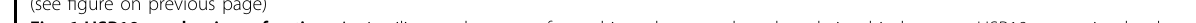
Fig. 6 USP19 mechanism of action. An in silico study was performed in order to analyze the relationship between USP19 expression levels and different pathway activation status. A USP19 mRNA expression among primary breast carcinomas according to their intrinsic subtype. Expression analysis showed a consistent upregulation in luminal A and B subtypes compared with basal-like and Her2 subtypes. B Luminal A/B primary breast cancers divided into low ( n = 77) or high ( n = 209) USP19 mRNA expression levels. C Signi fi cantly activated pathways among Luminal A/B tumors with high USP19 mRNA expression ( n ≥ 77, SAM test, p < 0.01). Western blotting was performed in order to analyze LRP6 protein expression in breast cancer cells upon USP19 genetic manipulation. D Top: Western blot quanti fi cation in control or USP19 silenced MDAMB231 cells ( n = 6, one-way ANOVA, Dunnett ’ s multiple comparison test. shRNA#1 p = 0.0416 and shRNA#2 p = 0.0102), bottom: representative image of a blot. E Top: Western blot quanti fi cation in MCF7 cells overexpressing control or GFP-tagged USP19 constructs ( n = 5, one-way ANOVA, Dunnett ’ s multiple comparison test. WT p = 0.0484, C506S p = 0.8469 and WT Δ TM p = 0.9968), bottom: representative image of a blot. F Wound-healing assays were performed in order to analyze endogenous LRP6 silencing effects in MCF7 cells overexpressing WT or C506S mutant versions of USP19. Cells were stably transduced with a control vector ( ‘ ctrol ’ , PLKO.1 empty vector), or shRNAs targeting LRP6 (sh#1 and sh#2). Scratching with a pipette tip made a gap on a monolayer of the different cell cultures, and time-lapse imaging monitored the number of migrating cells across the border. The graph shows the gap covered area (mm 2 ) after 8 h ( n = 3, Kruskal – Wallis and Dunn ’ s multiple comparison test for WT or C506S overexpressing MCF7 cell lines, analyzed separately. WT overexpressing MCF7 cell line: sh#1 p = 0.0341 and sh#2 p = 0.2021. C506S overexpressing MCF7 cell line: sh#1 p = 0.7422 and sh#2 p >